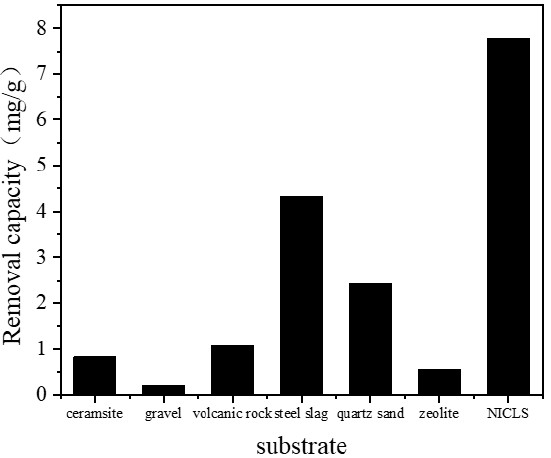
Figure6. Figure 6. Comparison of phosphorus removal performance of seven types of constructed wetland substrates.